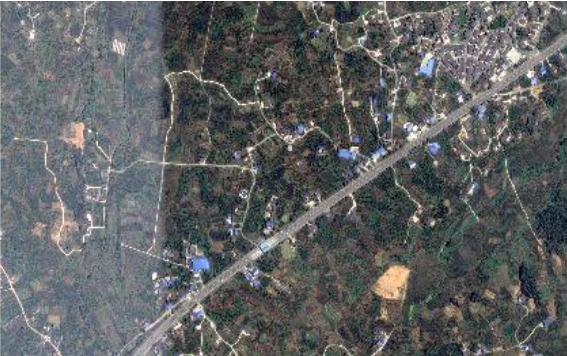
Figure 4. Orthophoto map of the test area